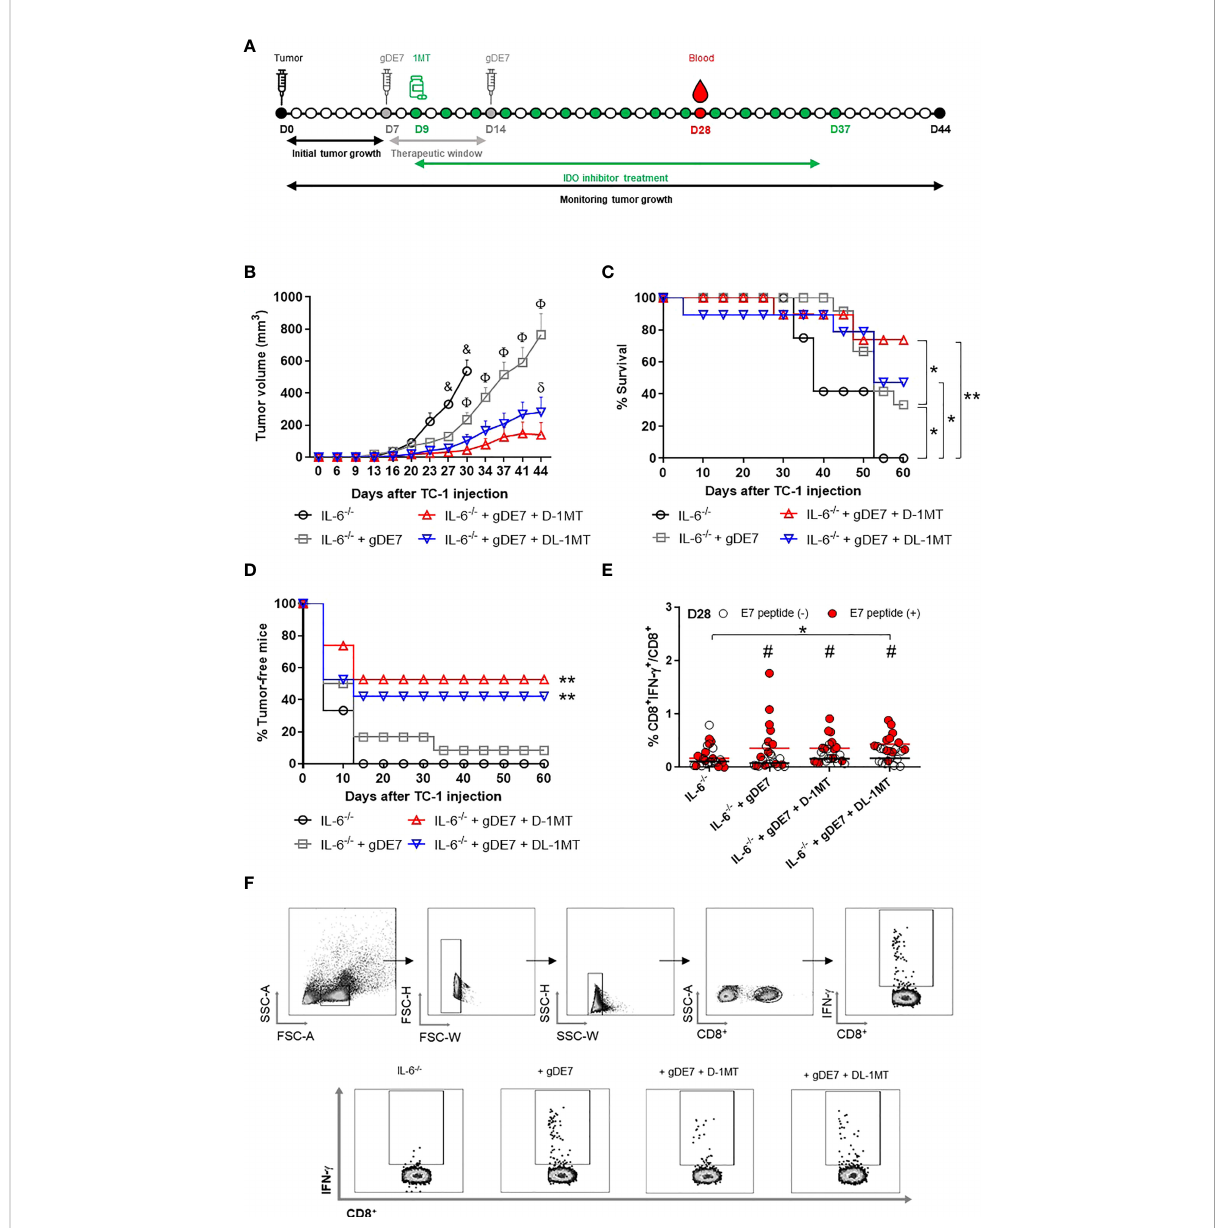
FIGURE 4 Lack of IL-6 combined with IDO inhibition augment immunotherapy control mediated by gDE7 on TC-1 cells engrafted in mice. (A) IL-6 -/- mice were subcutaneously inoculated with 1 x 10 5 TC-1 cells and vaccinated with two doses (D7 and D14) of gDE7 (30µg per animal). Two days after the fi rst dose (D9), mice were treated with 1MT at a concentration of 10 mg/animal every other day for four weeks, until D37. The experimental groups were followed for 60 days, but the “ endpoint data ” for each group was plotted up to the date when at least 80% of the mice were alive. (B-D) Data represent means ± SD from two (groups IL-6 -/- and IL-6 -/- + gDE7) (n=6, total n=12) or three (groups IL-6 -/- + gDE7 + 1MT) (n=6 or 7, total n=19) independently performed experiments with comparable results and analyzed by ANOVA or by Kaplan-Meyer test (exclusively for survival assay). The antitumor effects of gDE7 combined with 1MT isoforms were followed by (B) tumor volume (mm 3 ), (C) mice survival, and (D) presence of tumor-free mice. (C) Four, fourteen, and nine mice from IL-6 -/- + gDE7, IL-6 -/- + gDE7 + D-1MT, and IL-6 -/- + gDE7 + DL-1MT groups survived until day 60, respectively. (E) Frequency of circulating E7-speci fi c CD8 + IFN- g + /total CD8 + T cells on D28 after overnight ex- vivo stimulation of cells with the HPV-16 E7 Kb MHC class I-restricted immunodominant epitope peptide (n=12). (F) Gate strategy of